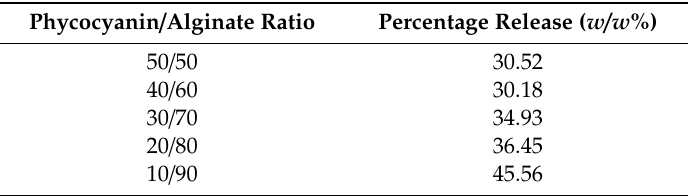
Figure 4. Releasing test of patches with various phycocyanin/alginate ratios. Table 2. Percentage of phycocyanin